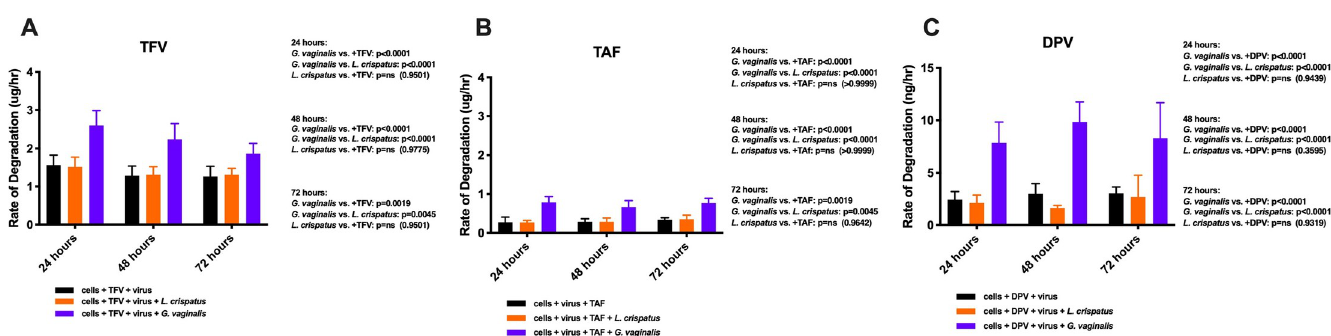
Fig 8. Degradation kinetics over time. (A) Rate of TFV degradation over time up to 72 hours. Purple G . vaginalis ; Orange, L . crispatus; Black, TFV alone. N = 6. (B) Rate of TAF degradation over time up to 72 hours. Purple G . vaginalis ; Orange, L . crispatus; Black, TAF alone. N = 6. (C) Rate of DPV degradation over time up to 72 hours. Purple G . vaginalis ; Orange, L . crispatus; Black, TAF alone. N = 6.